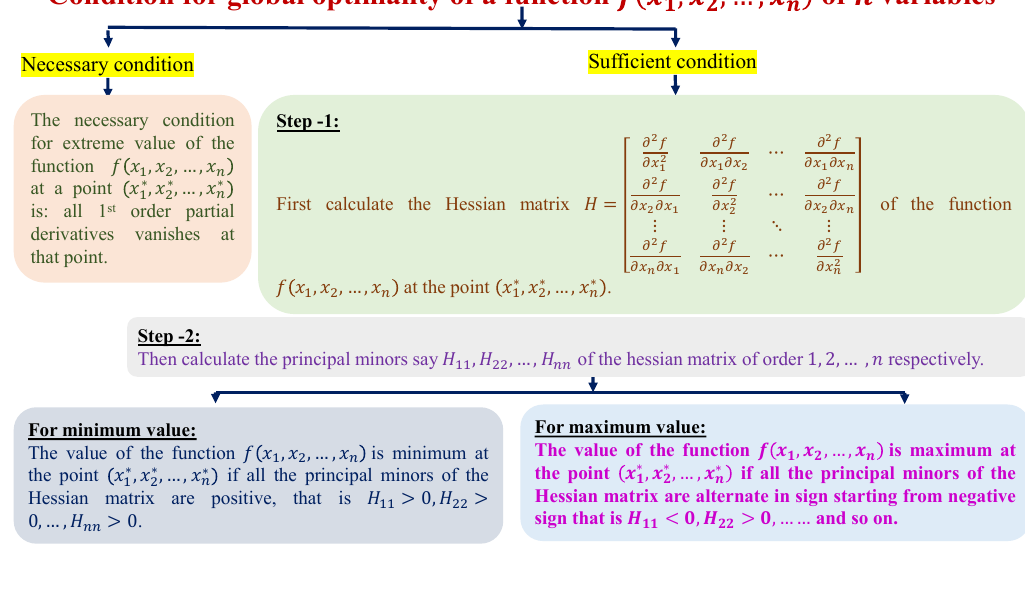
Figure 3. Framework of the classical optimization